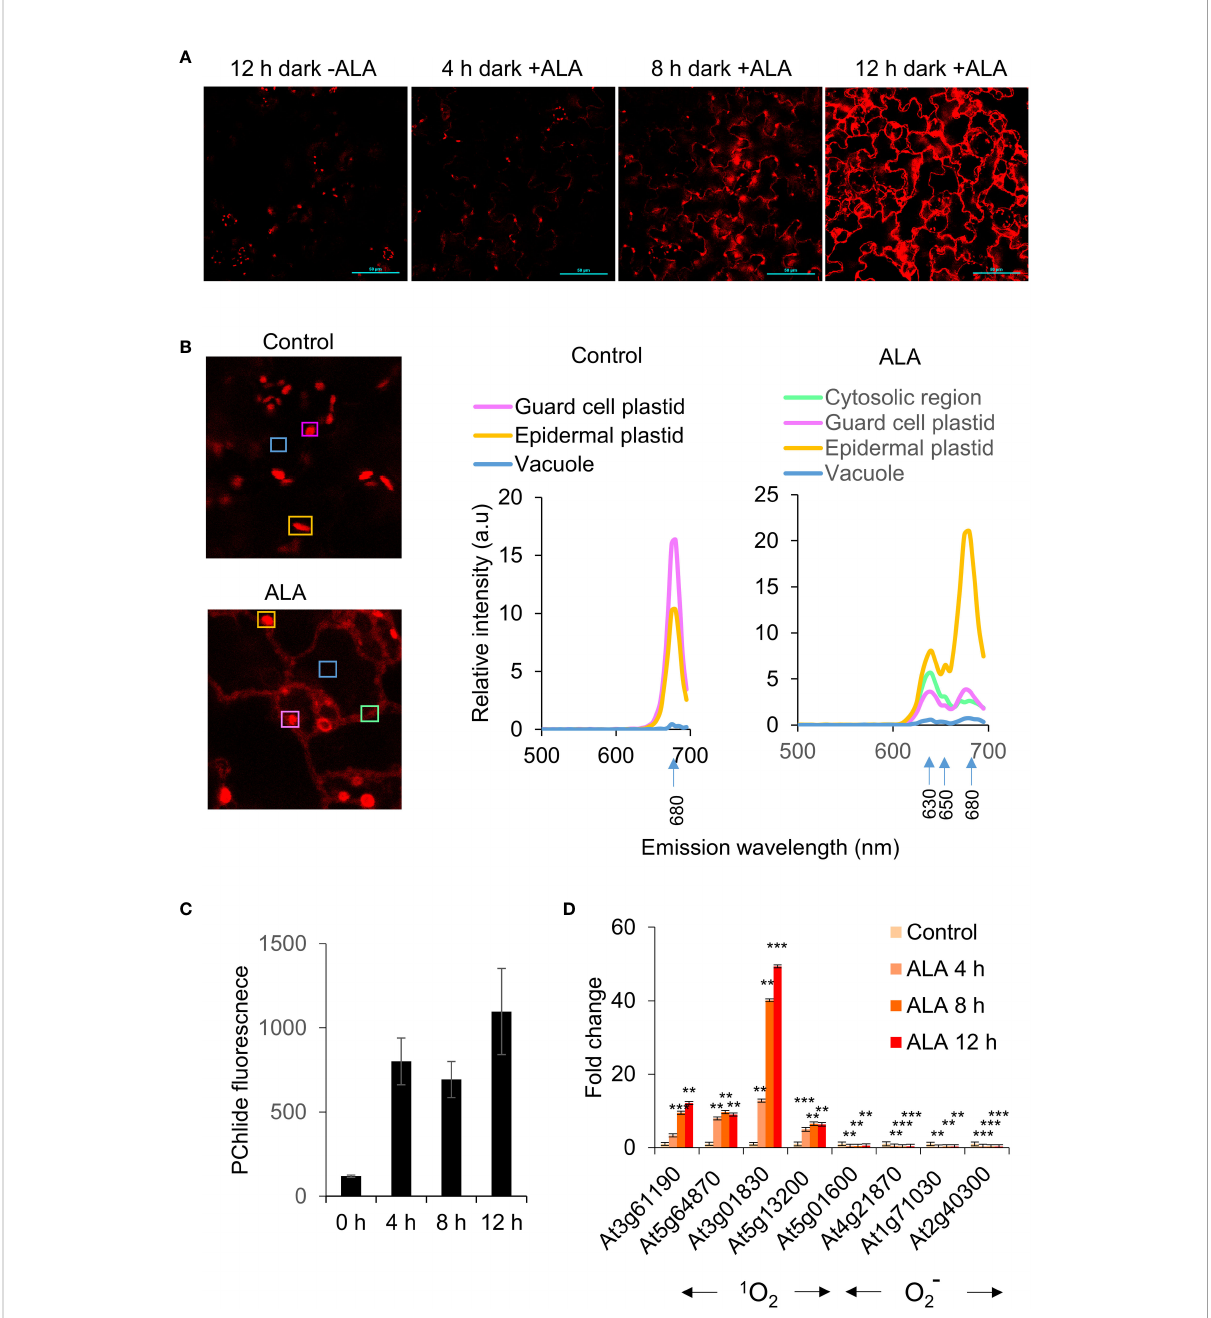
FIGURE 4 ALA feeding leads to extrachloroplastic accumulation of chlorophyll. (A) Accumulation of chlorophyll in extrachloroplastic regions under ALA treatment. Arabidopsis (WT, Col-0) seedlings were incubated with 1 mM ALA (in MS) in the dark for 12 h, and then mounted for visualisation as described in the Methods. Scale bar represents 50 µm. (B) (Left) Spectral imaging of Arabidopsis (WT, Col-0) seedlings were treated with DDW or 1 mM ALA (in DDW) and incubated in the dark for 2 h, and then mounted for visualisation by confocal microscopy as described in the Methods. Scale bar represents 50 µm. (Right) The areas indicated by boxes were scanned for spectral analyses as shown on the right. (C) Protochlorophyllide (Pchd) accumulation in ALA treated seedlings. Fluorescence was measured in WT seedlings (WT, Col-0) treated with 1 mM ALA (in MS) and incubated in the dark for 0, 4, 8, 12 h. Pchd fl uorescence was measured using a fl uorimeter (Ex/Em: 440/630 nm). The means and SE of 24 whole seedlings per time point are shown. (D) Arabidopsis (WT, Col-0) seedlings were incubated with 1 mM ALA (in MS) in the dark for 0, 4, 8, 12 h in the dark before 30 min exposure to low light (30 µE m -2 s -1 ). RNA was extracted and processed as described in the Materials and Methods for qRT-PCR analysis. The means and SE of three replicates is shown. Student ’ s t-test was performed against their respective controls for signi fi cance (** - P<0.01; *** - P<0.001). 1 O 2 sensitive genes as in Figure 3E. O − 2 sensitive genes: At5g01600 – Ferritin 1 (FER1), At4g21870 - heat shock protein family, At1g71030 - myb family transcription factor, At2g40300 - ferritin-related